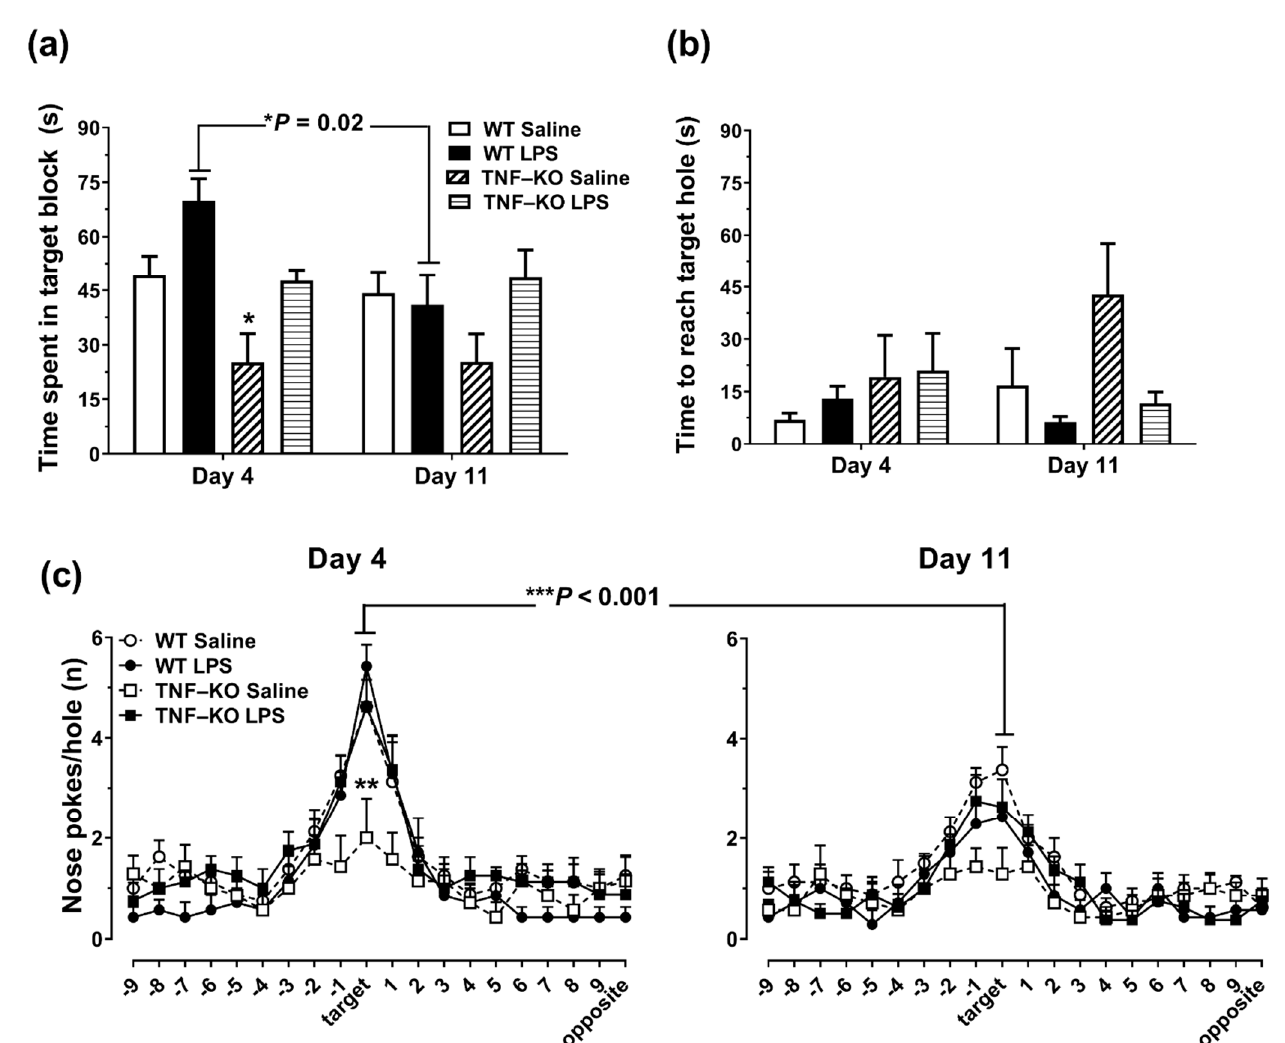
Figure 4. Memory-probing phase of the BMT in LPS- and PBS-treated WT and TNF-KO male mice. The escape box was removed for the probe sessions, which were conducted 24 h (DAY 4) and 7 days (DAY 11) following the acquisition phase. ( a ) On day 4, PBS-treated TNF-KO mice spent less time in the quarter of the arena where the escape box used to be situated (target block) compared to PBS-treated WT (* p < 0.05) and LPS-treated TNF-KO animals (* p < 0.05). Target block time was reduced in LPS-treated WT mice on DAY 11 vs. DAY 4 whereas PBS-treated WT mice had similar target block times on DAY 4 and DAY 11. ( b ) For primary latency, there were no between-group differences during the probing phase of the BMT. ( c ) The distribution of nose pokes across the BMT arena was practically random in PBS-treated TNF-KO mice. On DAY 4, the number of nose-pokes at the escape hole was lower in PBS-treated TNF-KO mice compared to all other groups examined (** p < 0.01). On DAY 11 vs. DAY 4, there was a time-dependent reduction in the number of target hole nose-pokes in all groups, except for PBS-treated TNF-KO mice. Results are the mean ± SEM of n = 7–8 mice per group and were analyzed using repeated measures ANOVA and Bonferroni post hoc tests.